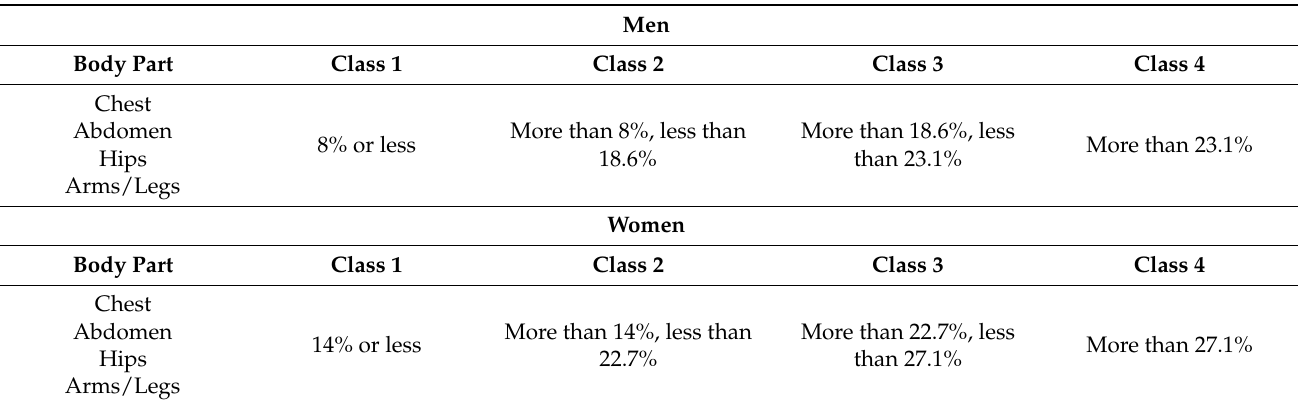
Table 4. Class values defined for each body